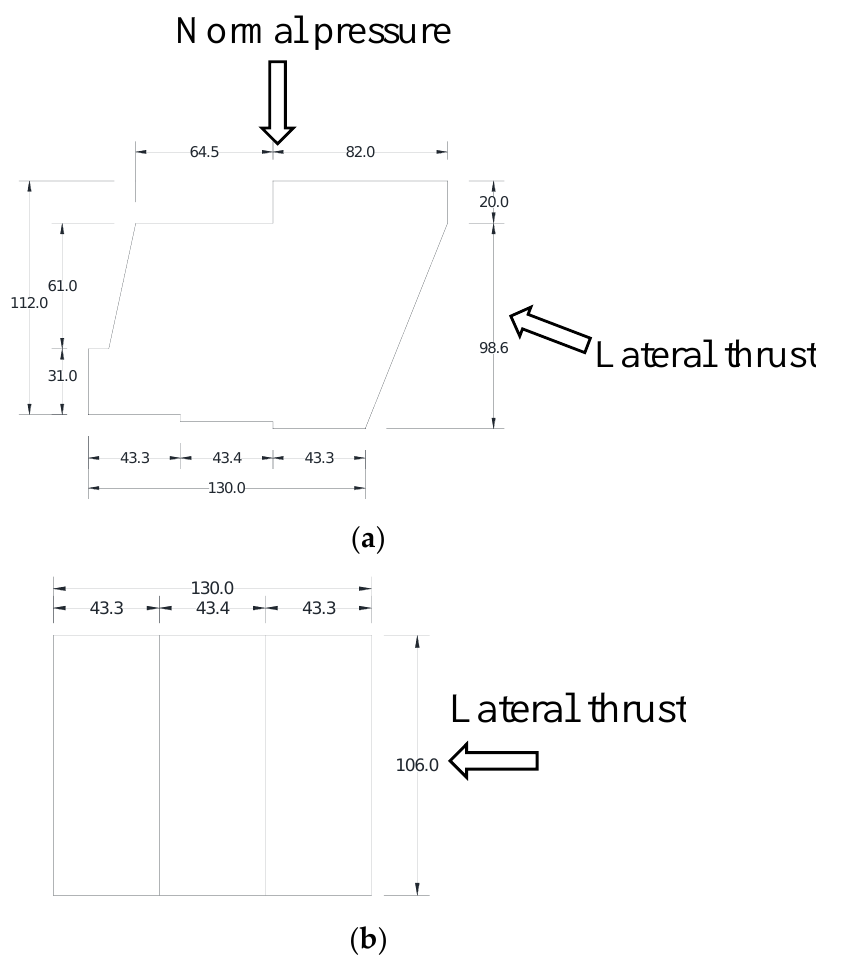
Figure 7. Schematic geometry of scale anchorage model (Unit in cm). ( a ) Side view, ( b ) Plane view. A 3D DEM model of the scale anchorage model was established to numerically ana- lyze the stress conditions and mechanical behavior of the concrete-rock interface, as shown in Figure 8. The mechanical parameters for numerical simulation were determined by the above-mentioned in-situ direct shear test results.